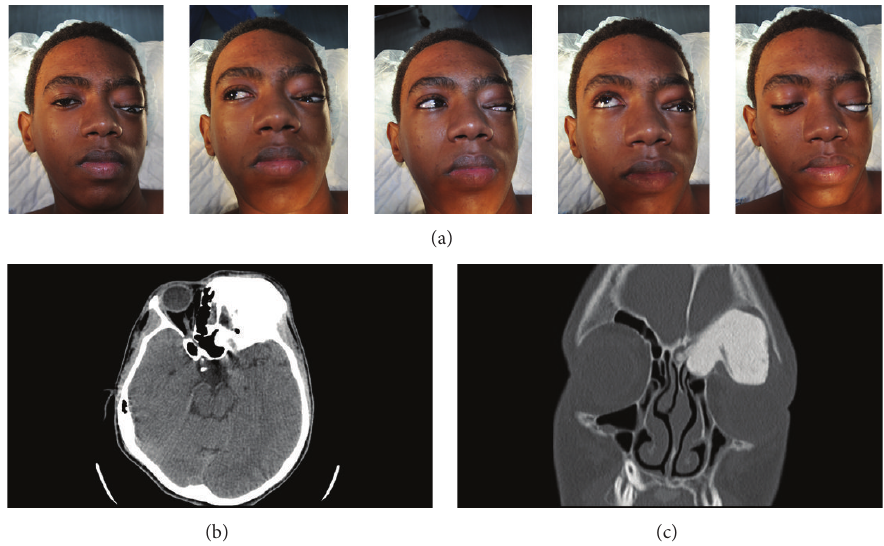
Figure 1: Patient photo demonstrating the degree of proptosis and limitation of eyemovements (a). Computerized tomography (axial (b) and coronal (c)) depicting giant osteoma feature at the orbitoethemoidal region and the degree of orbital compression.